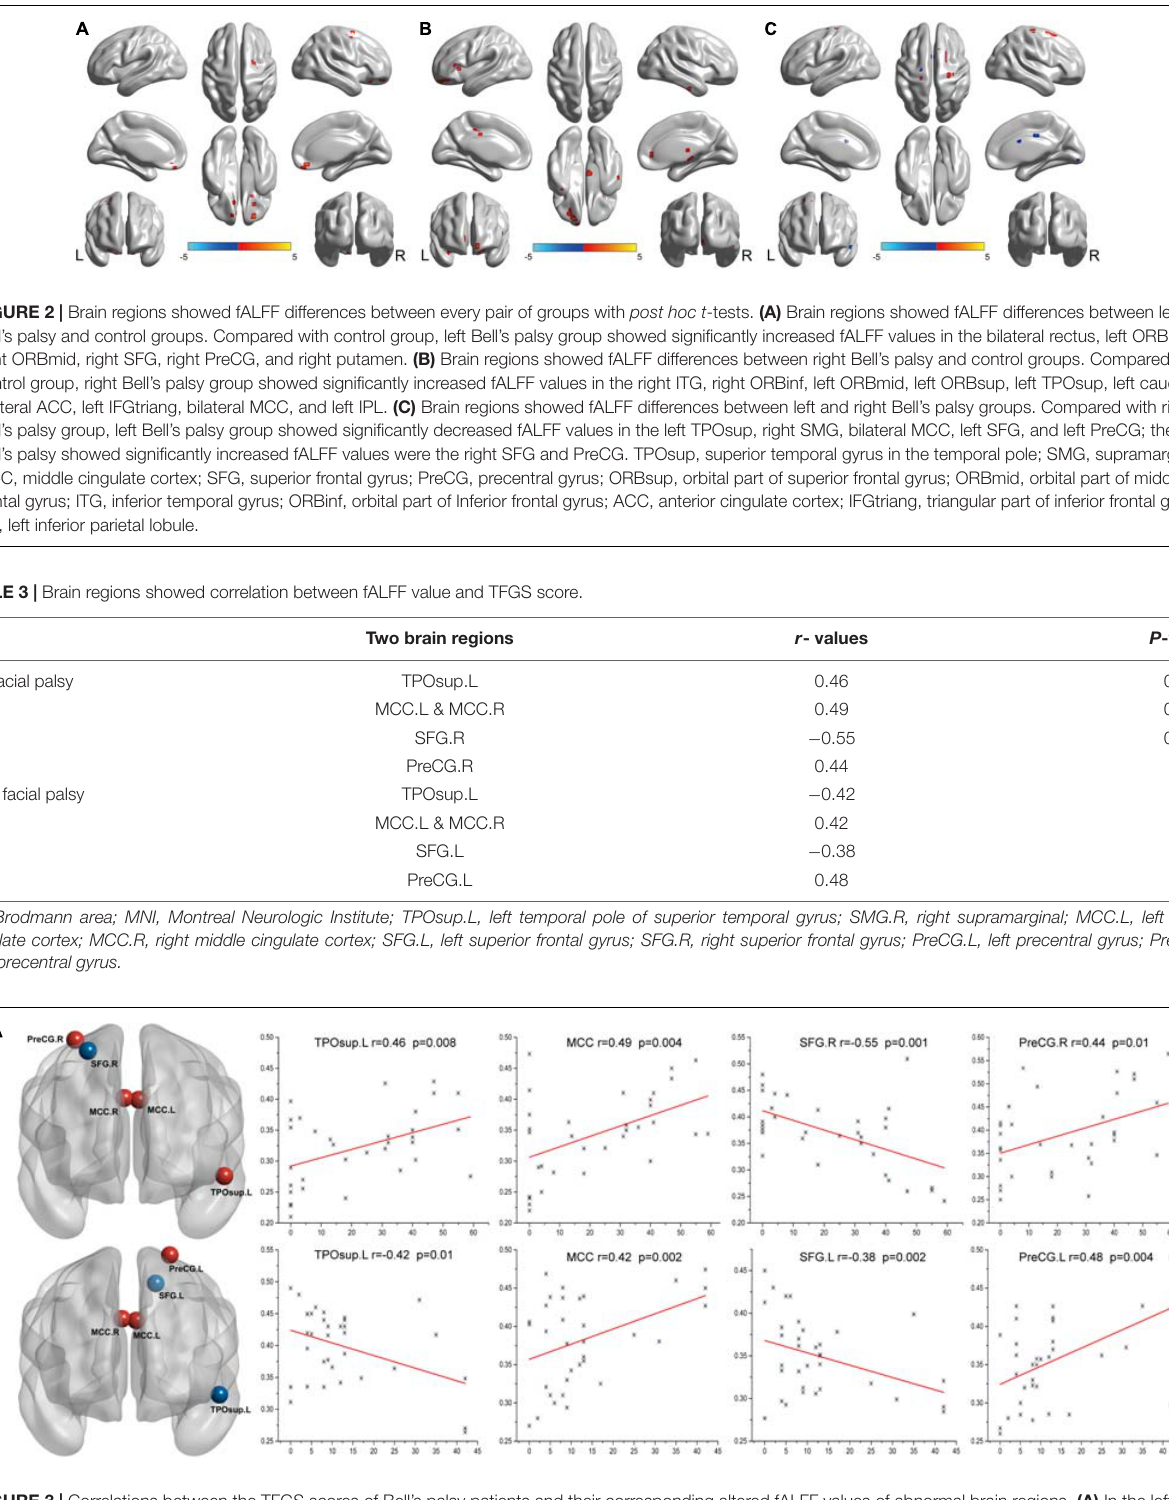
FIGURE 3 | Correlations between the TFGS scores of Bell’s palsy patients and their corresponding altered fALFF values of abnormal brain regions. (A) In the left Bell’s palsy group, the brain regions showing a positive correlation were the left TPOsup, bilateral MCC, and right PreCG; the brain region indicating a negative correlation was the right SFG. (B) In the right Bell’s palsy group, the brain regions showing a positive correlation were the bilateral MCC and left PreCG; the brain regions showing a negative correlation were the left TPOsup and SFG. TPOsup, superior temporal gyrus in the temporal pole; MCC, middle cingulate cortex; PreCG, precentral gyrus; SFG, superior frontal